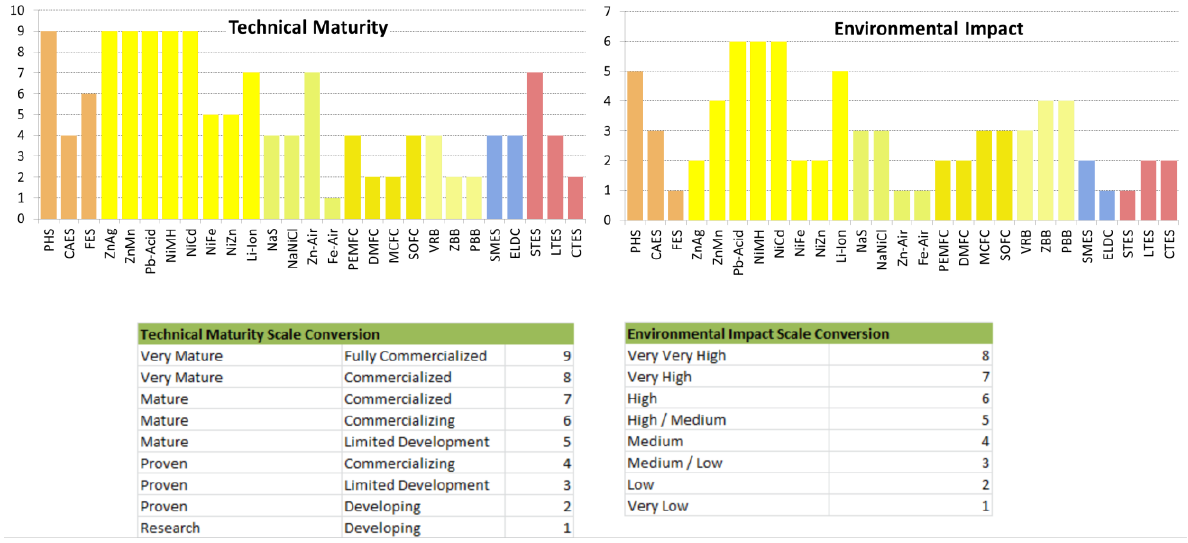
Figure 15. Comparing qualitative metrics: technical maturity and environmental impact. Data points marked with “X” are